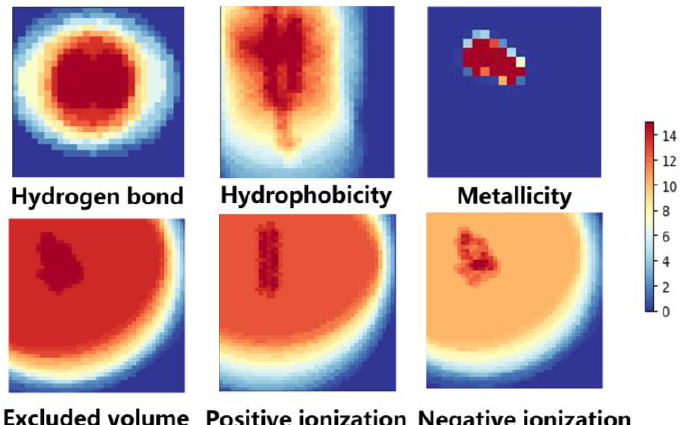
Figure 3. Heat map of six descriptors. The distribution of a two-dimensional grid of the five channels (positive / negative ionization, excluded volume, metallicity and hydrophobicity) were calculated using Van der Waals force-based grid method, and one channel about the hydrogen bond used the hydrogen bond-based grid method.